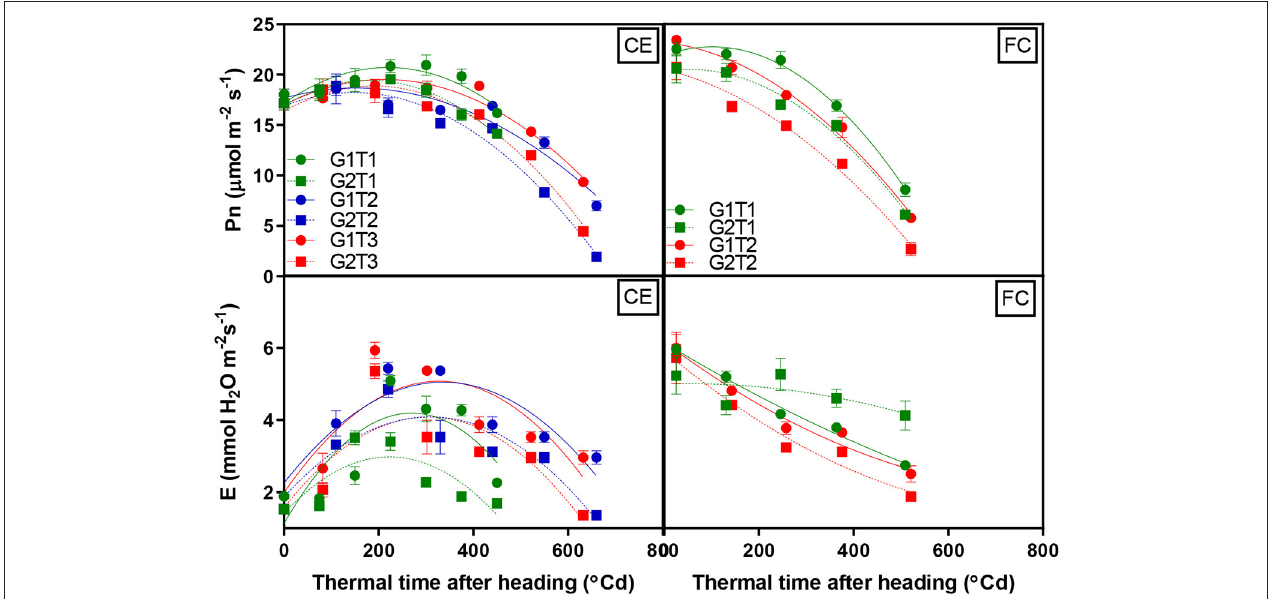
FIGURE 4 | Change in net photosynthesis and transpiration rates over time for two wheat genotypes (G1, putative heat tolerant, circles and solid lines; G2, putative heat susceptible, squares and dotted lines) in response to day/night temperatures of CET1 [control (22/14 ◦ C)], CET2 (30/20 ◦ C from the heading), and CET3 (30/20 ◦ C from anthesis) under controlled environment conditions (CE) or heat chambers in the field (FC) (FCT1, ambient temperature chamber and FCT2, heated chamber). Error bars represent SEM, n = 4.